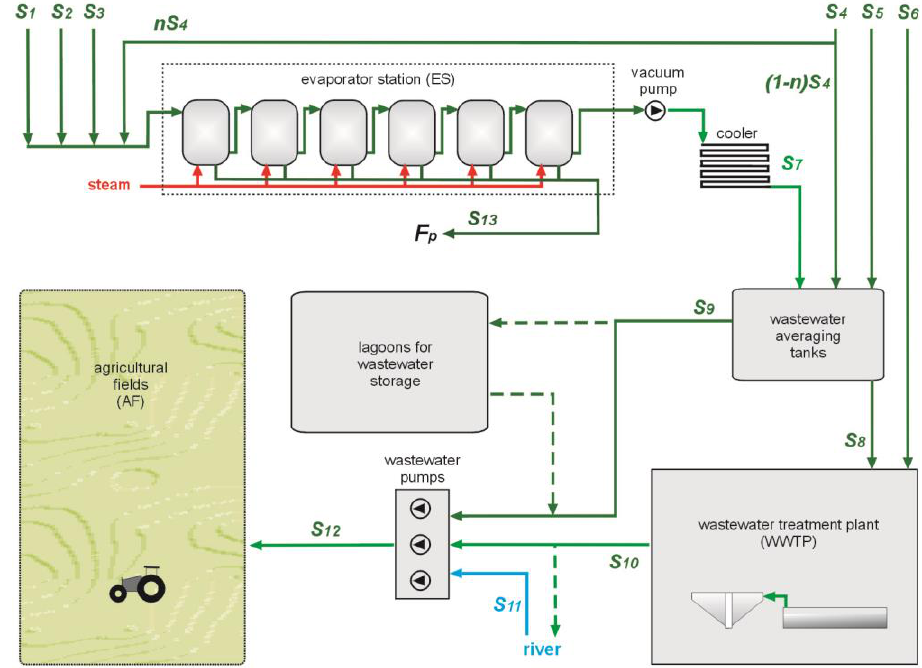
Figure 2. Scheme of three-stage wastewater treatment (agricultural field, evaporator station, and a biological wastewater treatment plant) system, with an additional nS 4 stream directed to the evaporator station.